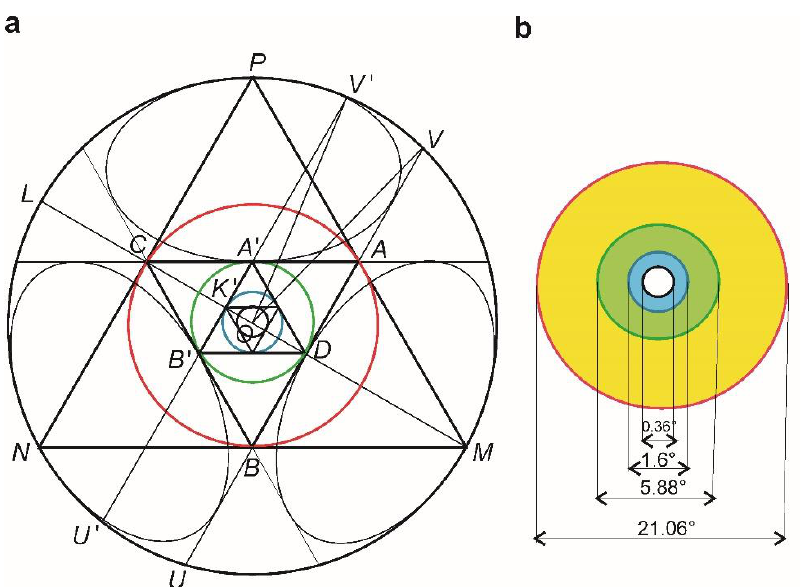
Figure 4. The macula hyperbolic structure. ( a ) In the HGKB model, the equilateral triangles (EQTs) successively inscribed to the horizon circle lead to a correspondence between the hyperbolic angles of the triangles complementary to 60° and the angular eccentricities of the macular regions. The red circle represents the macula, the green circle represents the fovea (FV), and the blue circle represents the foveal avascular zone (FAZ), while the black circle is the umbo. ( b ) The yellow disc comprises the perifoveal and parafoveal areas, the green one represents the FV and the blue disc represents the FAZ and foveal areas, while the white disc represents the umbo.